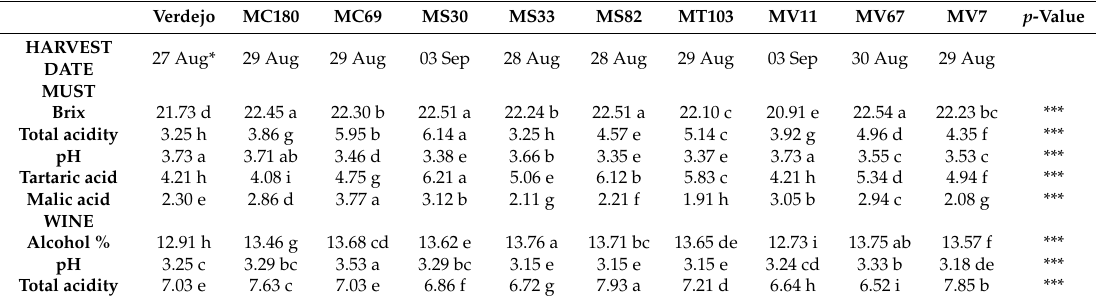
Table 1. Analytical parameters in must at harvest and in wine at the end of alcoholic fermentation in 2018 season.